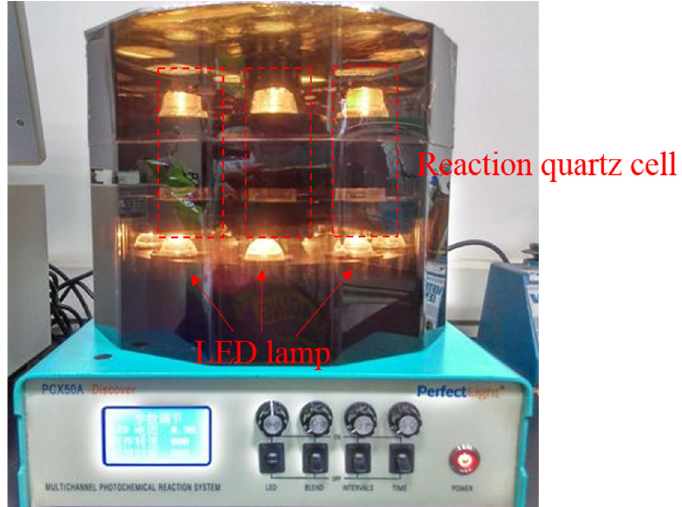
Figure A1. The image of a multichannel photochemical reaction system. A detailed description of the multichannel photochemical reaction system can be found in the following link. Https: //www.perfectlight.com.cn/Product/detail/id/35.html (visited on 9 May